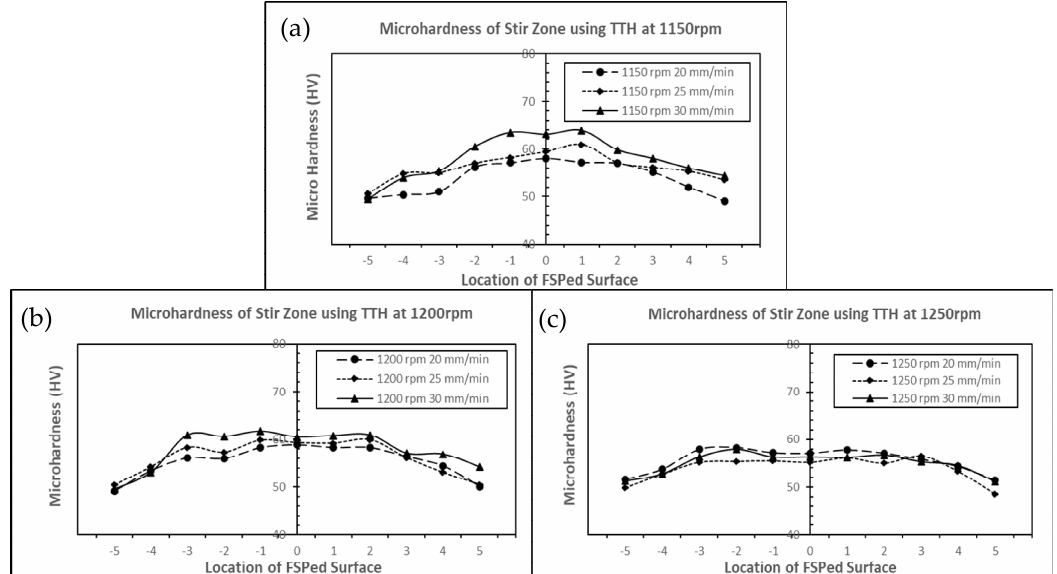
Figure 7. Stir zone microhardness of FSPed sample produced at, ( a ) 1150 rpm, ( b ) 1200 rpm, and ( c ) 1250 rpm using TTH tool with different feed rates.